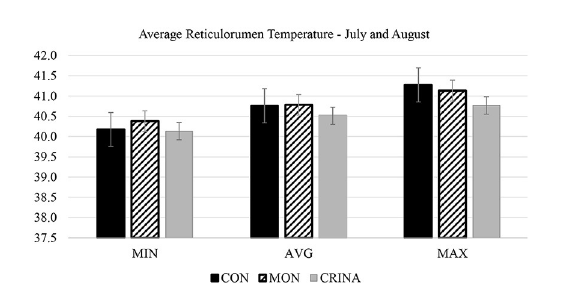
FIGURE2 Average reticulorumen temperature during July and